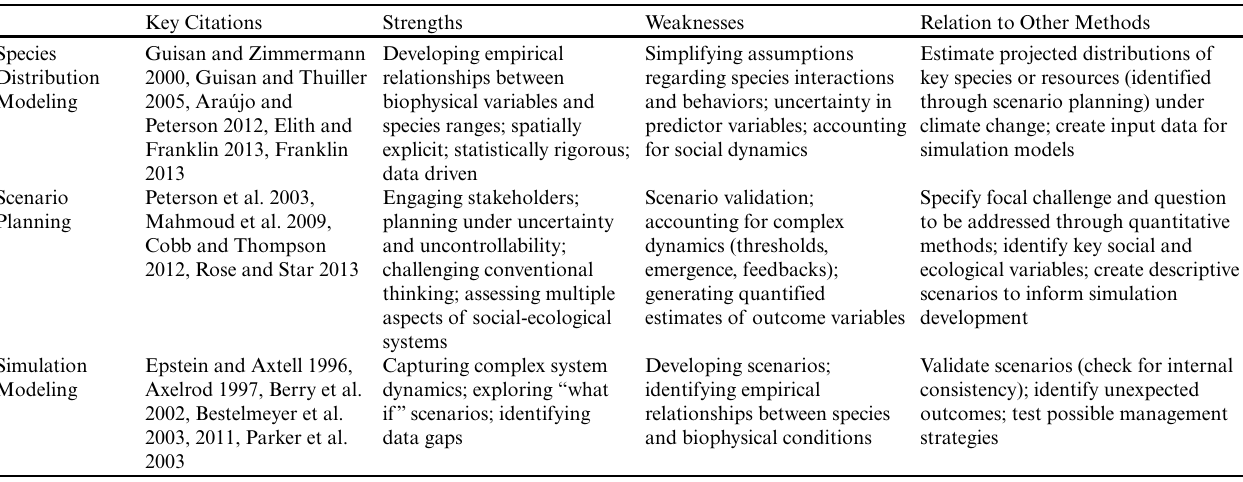
Table 1 . Summary of three tools for assisting climate change planning. Key